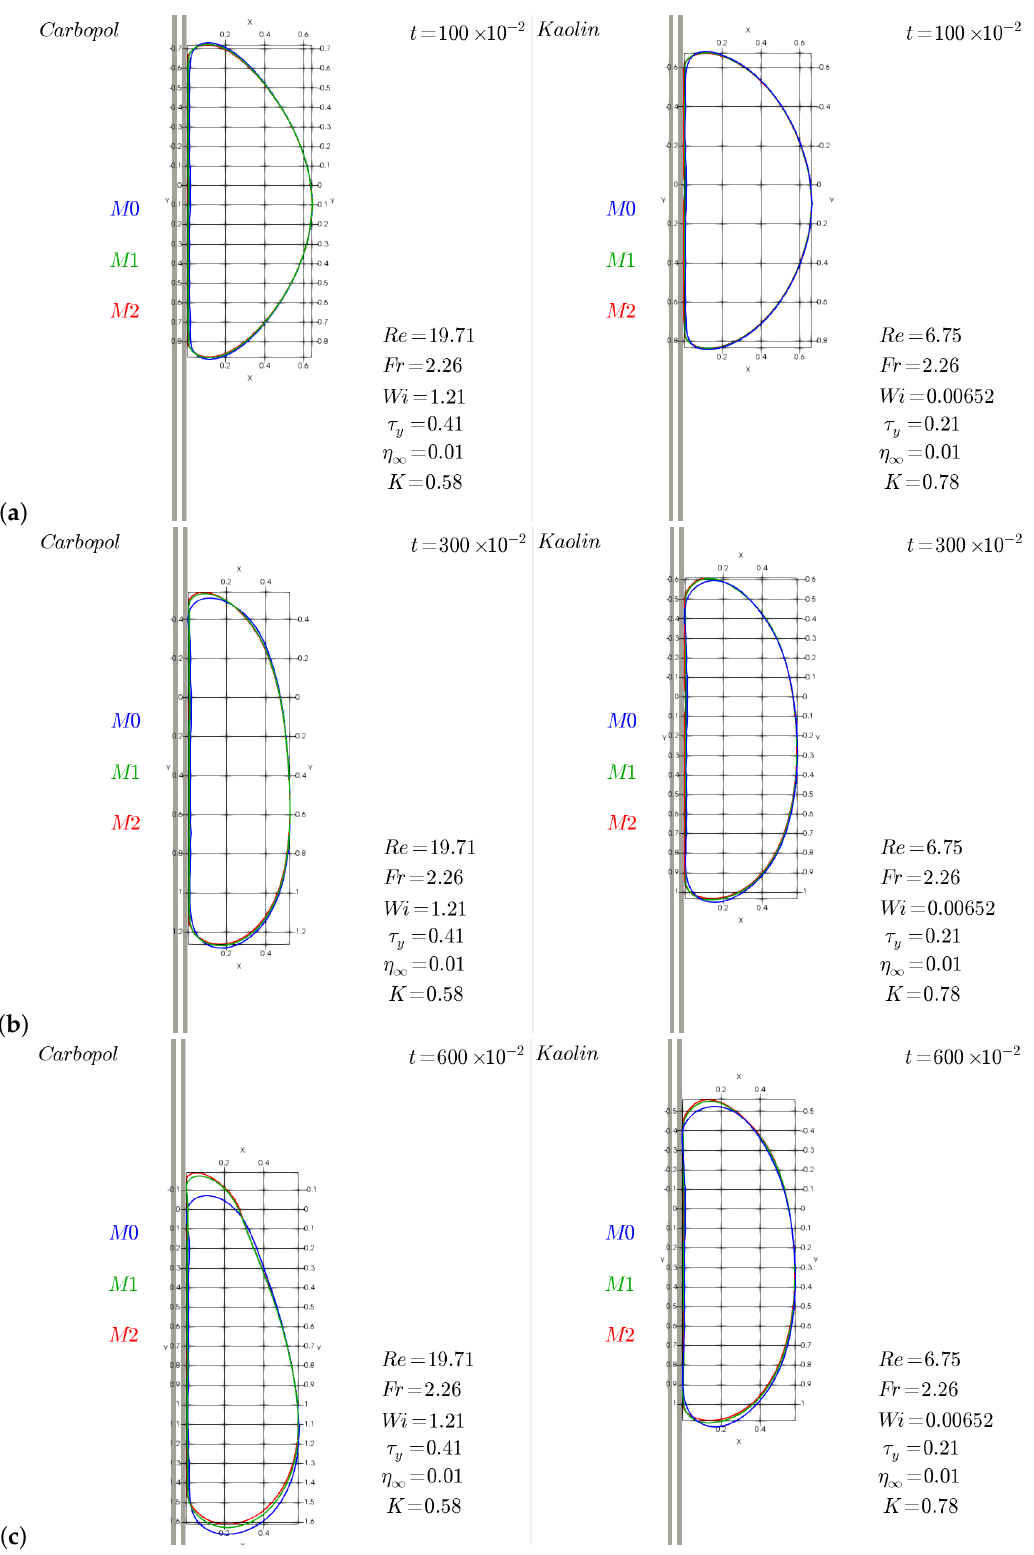
Figure 2. Collision of drops on a vertical wall for Carbopol ( left ) and Kaolin ( right ) materials using three different meshes (M1, M2 and M3): ( a ) Dimensionless time, t = 1; ( b ) Dimensionless time, t = 3 and ( c ) Dimensionless time, t =